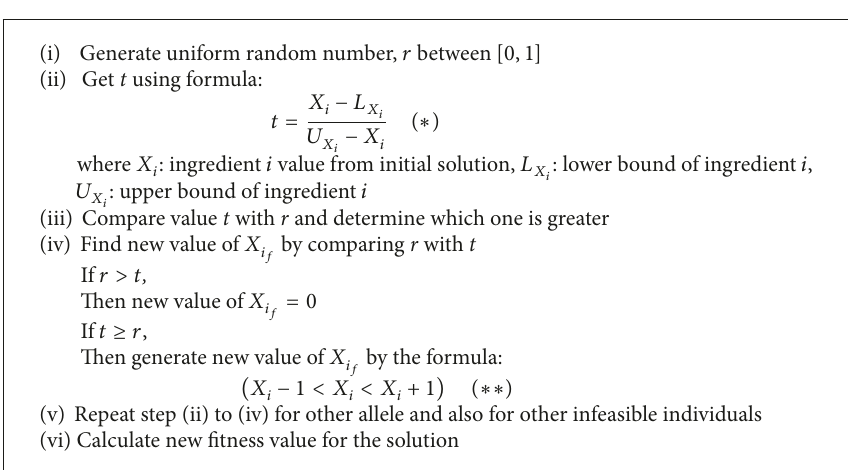
algorithm from Algorithm 1. Experimentations of EA